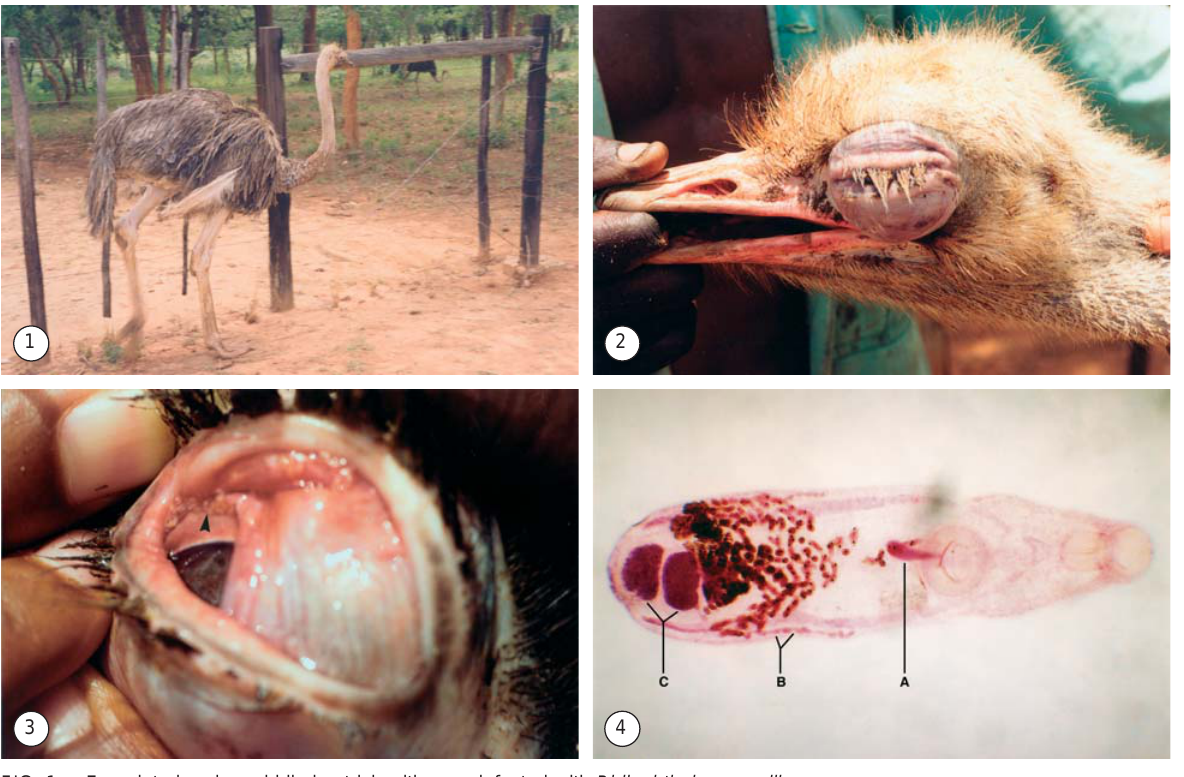
FIG. 1 Emaciated and semi-blind ostrich with eyes infected with Philophthalmus gralli FIG. 2 Swollen eyelids due to heavy infection with Philophthalmus gralli FIG. 3 Philophthalmus gralli (arrow) attached to the conjuctival sac of an ostrich eye FIG. 4 Adult Philophthalmus gralli from the eye of an ostrich. X 3.2. Cirrus extends beyond the ventral sucker (A), strong ventral sucker with ventral sucker/oral sucker ratio approximately 1:1.5, vitelline glands tubular to follicular (B) and spherical testis arranged in tandem TABLE 1 Prevalence of Philopthalmus gralli in field and laboratory-bred Melanoides tuberculata Source of